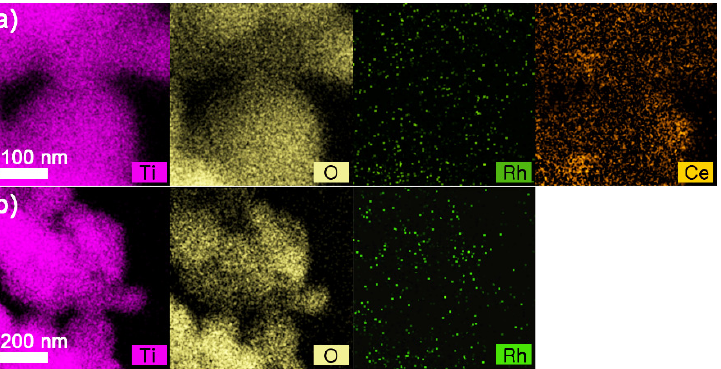
Figure 4. Elemental mapping images of ( a ) Rh–TiO 2 –CeO 2 and ( b ) Rh–TiO 2 hybrid photocatalysts.